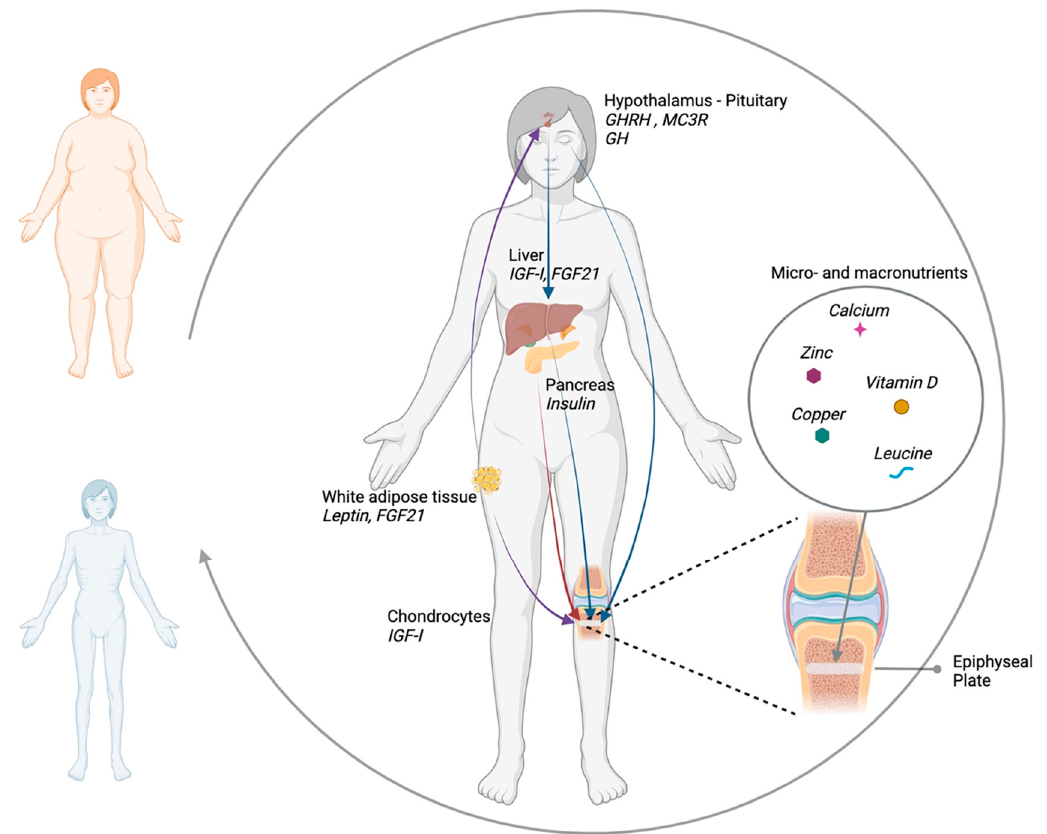
Figure 1. Schematic representation of the interplay between nutritional status and endocrine regulators of growth: growth hormone (GH) resistance induced by prolonged fasting impairs GH direct and insulin-like growth factor I (IGF-I) mediated action on chondrocytes. The increased secretion of fibroblast growth factor 21 (FGF21) by liver and adipose tissue in malnutrition contributes to GH resistance by reducing hepatic GH receptors expression and disrupting GH action in the growth plate. Insulin promotes growth by acting both directly on chondrocytes and indirectly, stimulating IGF-I production. Leptin, produced by adipose tissue, stimulates growth hormone-releasing hormone (GHRH) secretion by the hypothalamus and exerts a direct peripheral growth-promoting effect in the growth plate by stimulating chondrocyte proliferation and differentiation. Hypothalamic melanocortin 3 receptor (MC3R) integrates signals of metabolic status that affect body growth and sexual maturation. Micronutrients such as zinc, copper, calcium, vitamin D and macronutrients such as aminoacids, in particular leucine, exert a direct effect on the epiphyseal growth plate by influencing chondrocyte differentiation and proliferation.